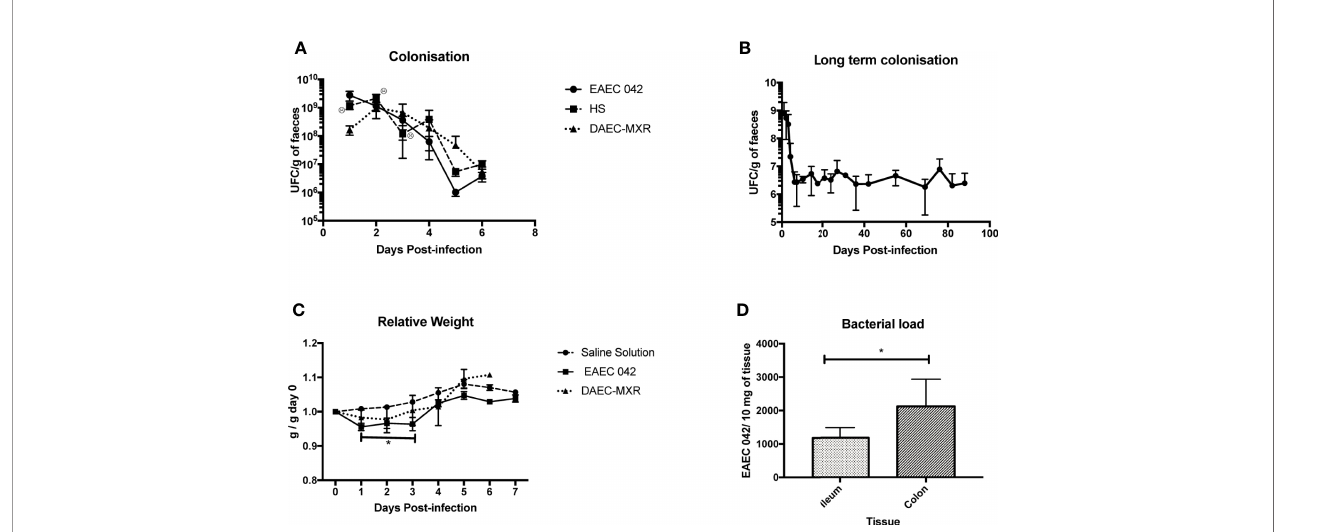
FIGURE 1 | Evaluation and characterization of C57BL/6 mice infected with EAEC 042. (A) Colonization of C57BL/6 mice with EAEC 042, DAEC-MXR, and HS at a 5 × 10 9 dose. Fecal samples were collected and weighed every day in a sterile environment. Bacterial concentration in feces was determined by CFU/g. Colonization results for EAEC 042 are the mean of three independent experiments of fi ve mice each. In the fi rst colonization experiment, fi ve and seven mice were infected with EAEC 042 and HS strains, respectively. In the second experiment, fi ve and six mice were infected with EAEC 042 and DAEC-MXR, respectively. In the third experiment, only EAEC 042 strain was used. No bacterial growth was observed on MacConkey agar plate after culturing feces from control mice from the three experiments, inoculated with saline solution (SS) (N = 12). (B) Long-term colonization with EAEC 042; three mice from experiment three were followed up for 90 days. (C) Relative weight of mice after inoculation with EAEC 042, DAEC-MXR, and SS. The relative weight was calculated as the day weight post-infection divided by the weight before infection (day 0). Results are the mean of three independent experiments with saline solution (SS) (N = 12) and EAEC 042 (N = 15) and 1 experiment with DAEC-MXR (N = 6), * p < 0.05. (D) Intestinal bacteria load. On day 7, post-infection DNA from ileum (N = 5) and colon (N = 7) of EAEC 042-infected mice was obtained. By real-time PCR, aii C gene (a speci fi c chromosomic marker of EAEC 042) was screened, * p < 0.05. EAEC, enteroaggregative Escherichia coli ; CFU, colony-forming